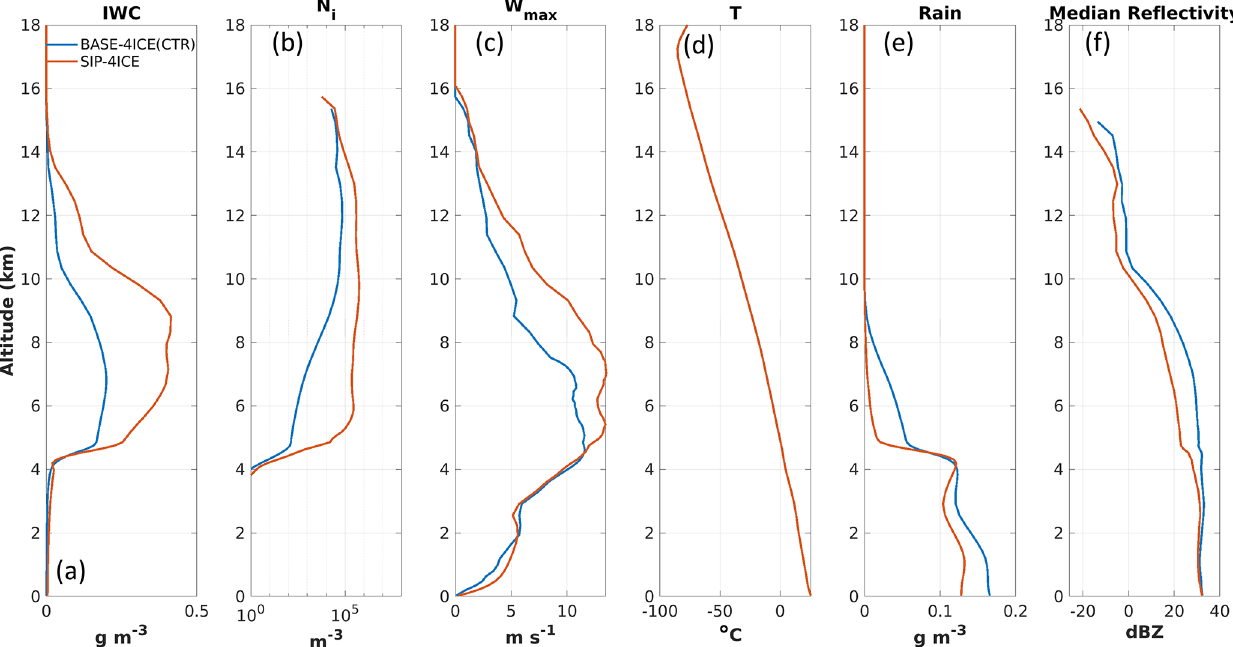
Figure 6. Same as Fig. 4 but for the baseline (CTR) simulation with four ice categories and the SIP simulation with four ice